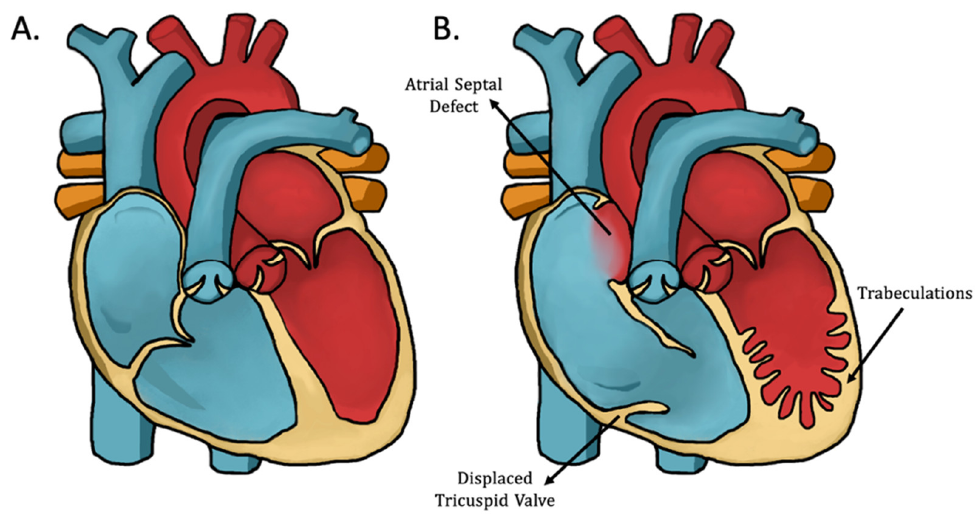
Figure 1. Illustration of EA/LVNC morphology: ( A ) normal heart; ( B ) morphological defects seen in EA/LVNC. Common characteristics depicted here are the apical displacement of the tricuspid valve, dilation of the right atrioventricular junction, trabeculated left ventricular myocardium, and an atrial septal defect (a common comorbidity of EA/LVNC). EA/LVNC; Ebstein’s anomaly with left ventricular noncompaction.